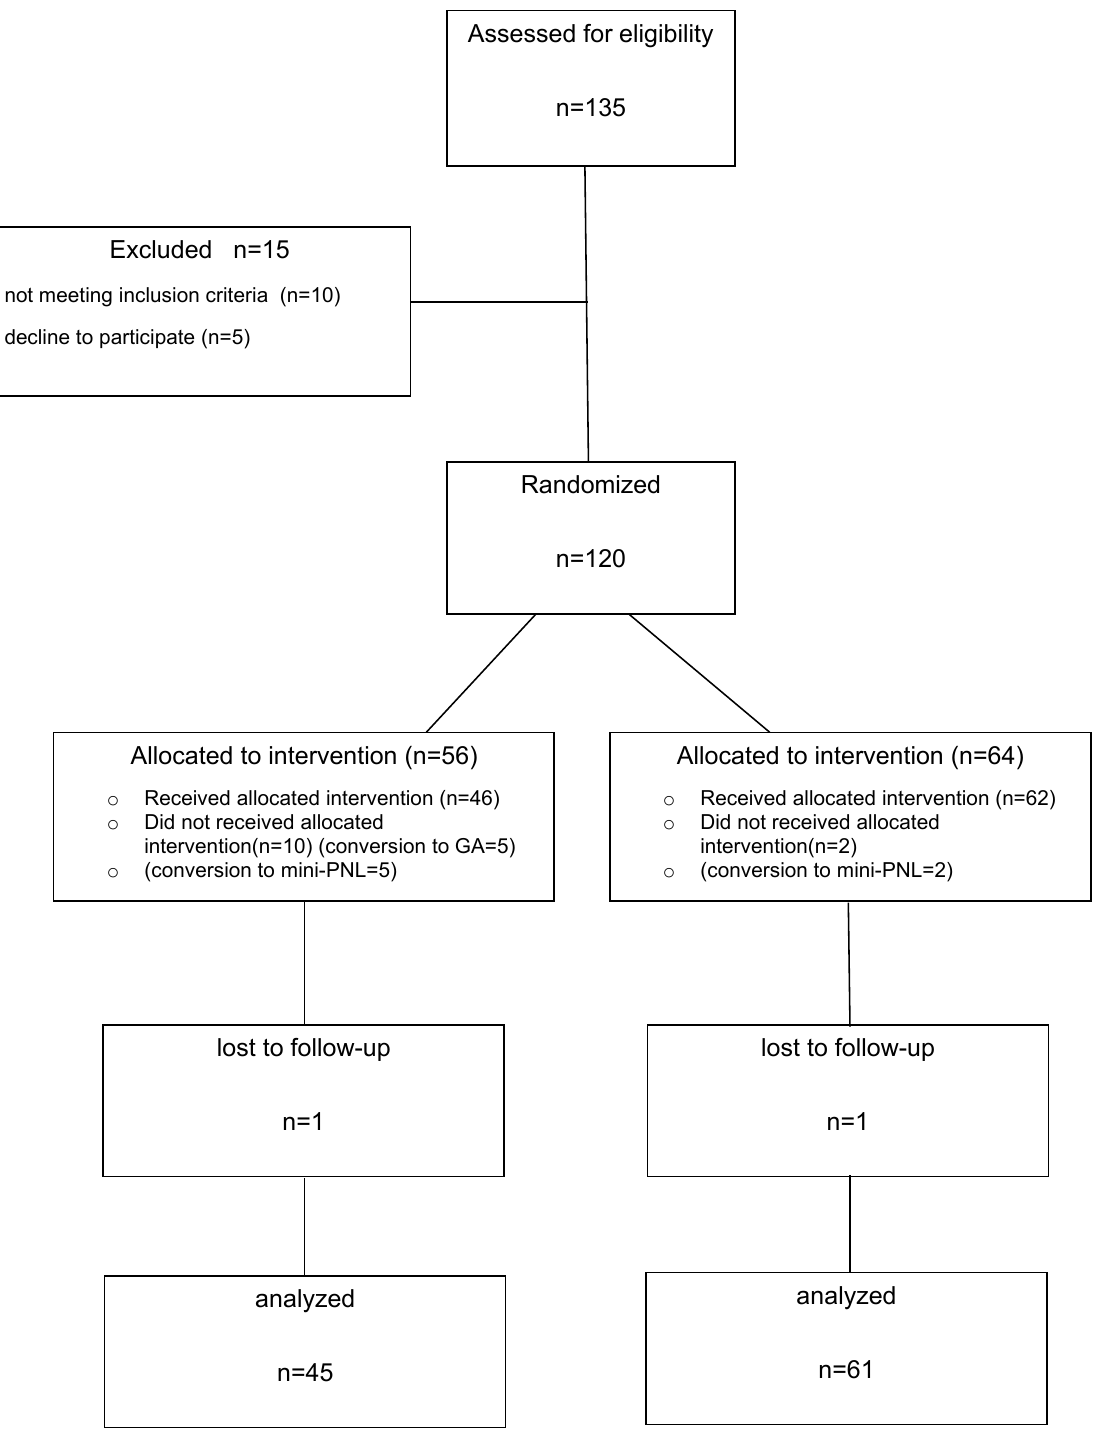
Figure 1 - Consort diagram showing study